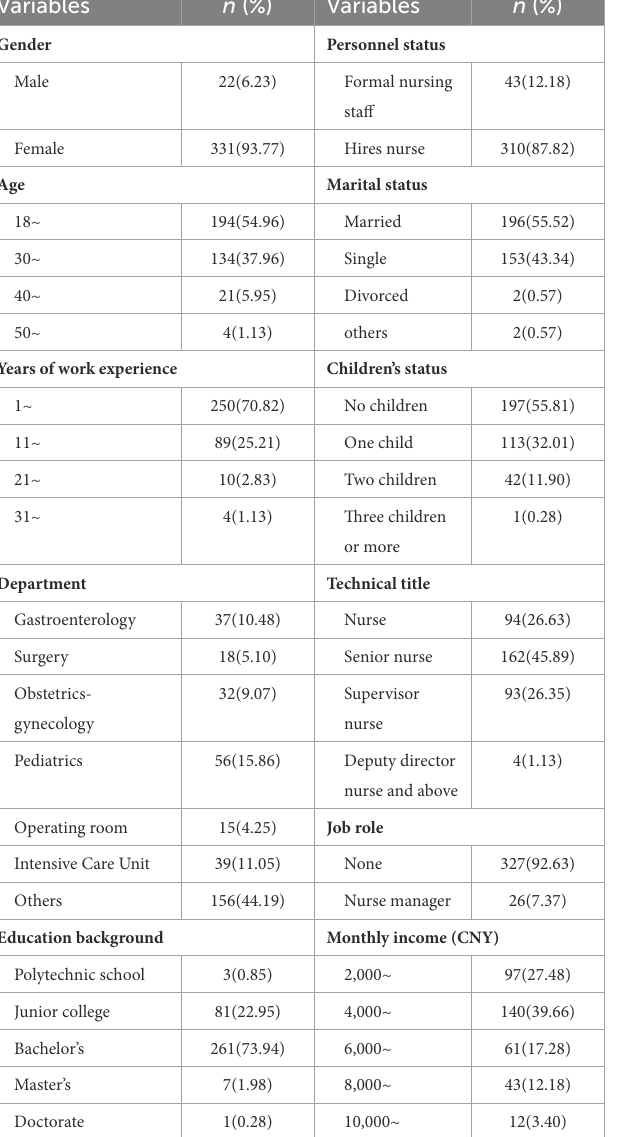
TABLE 1 Nurse characteristics ( n =